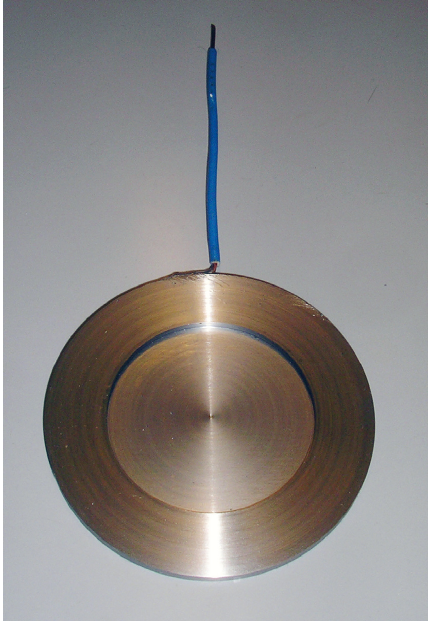
Figure 3: Test sample after turning. The middle part is for hy- drogen permeation and the machined side was in the hydrogen evolving